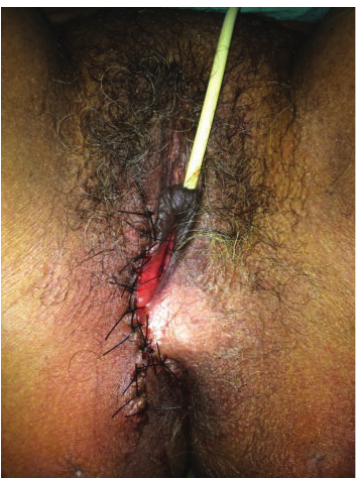
Figure 3: View of the completed surgical